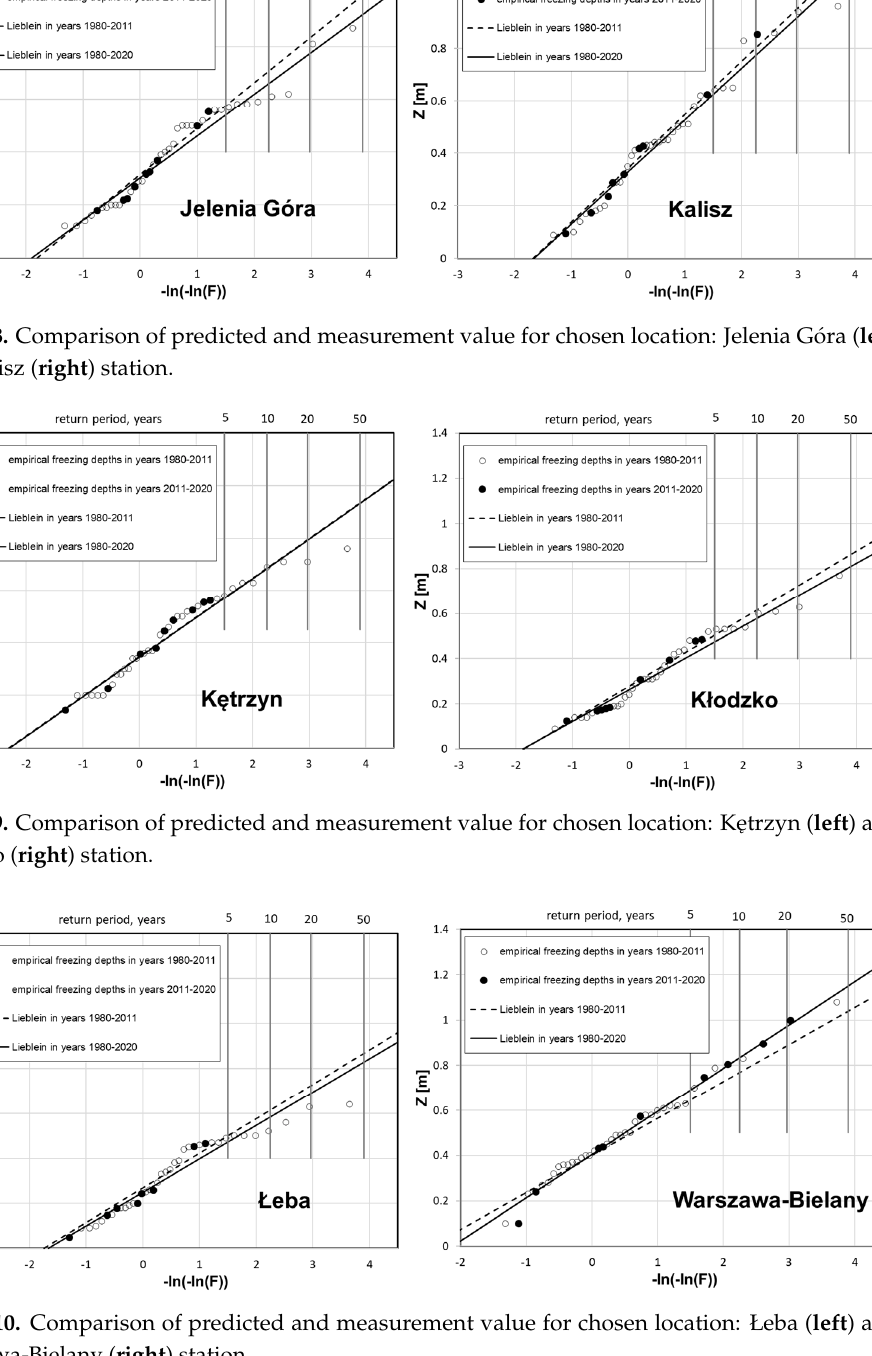
Figure 10. Comparison of predicted and measurement value for chosen location: Łeba ( left ) and Warszawa-Bielany ( right ) station .